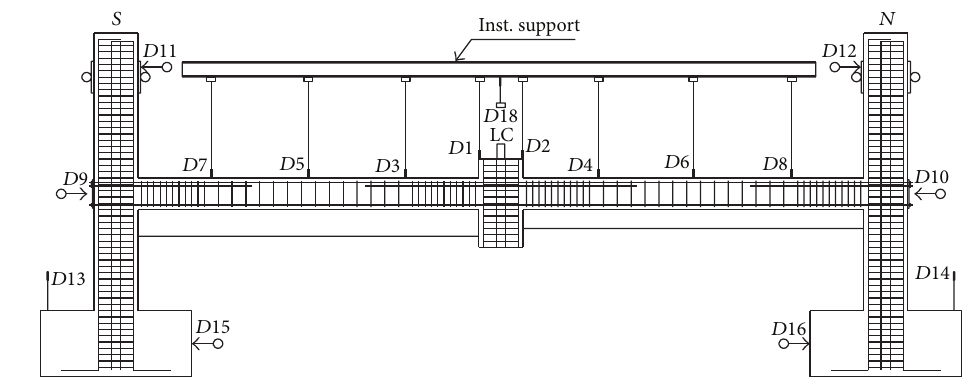
Figure 2: Details of the scaled specimen.